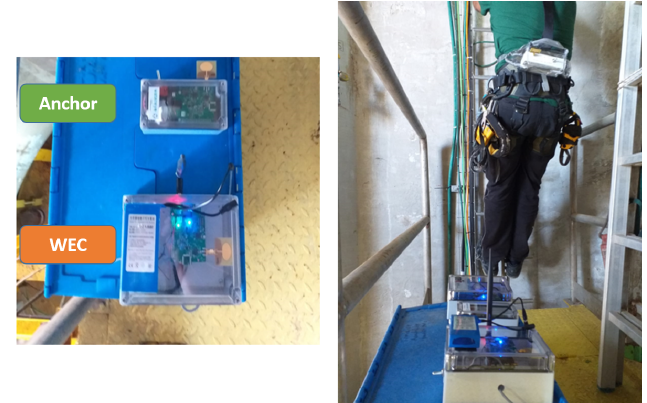
Figure 19. Communications system deployed inside the ELICAN prototype.